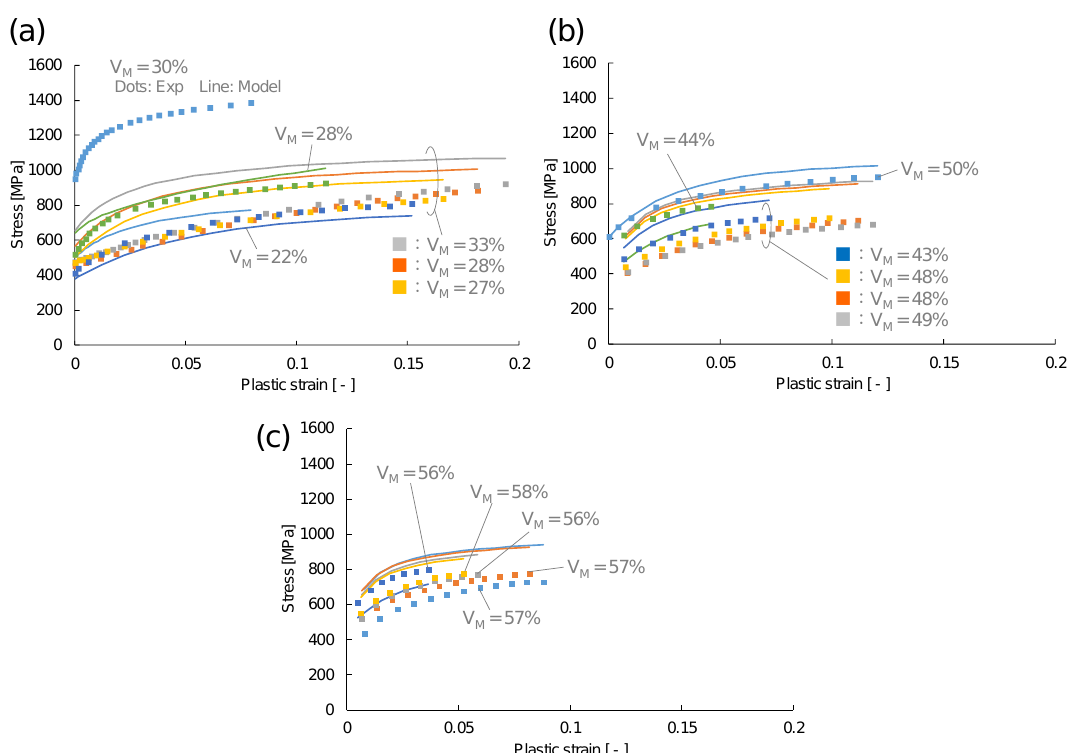
Figure 13. Stress–strain curve predictions for DP steels which martensite volume fraction V M is: ( a ) less than 40%; ( b ) 40% to 50%; and ( c ) larger than 50%, respectively.